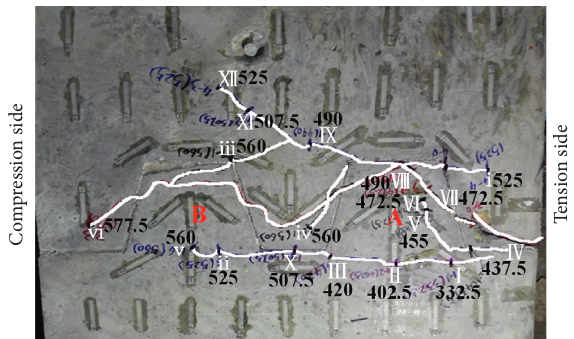
Figure 5: Crack development of double mortise-tenon joint without auxiliary pretightening device (axial load